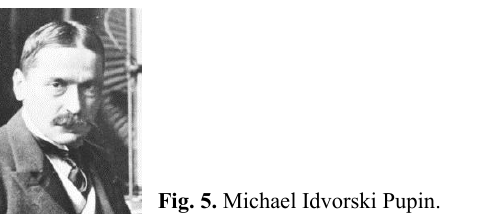
Fig. 5. Michael Idvorski Pupin.